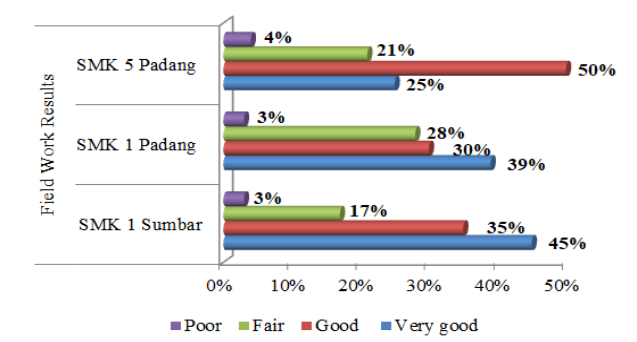
Fig. 1 Percentage of achievements in fieldwork of each